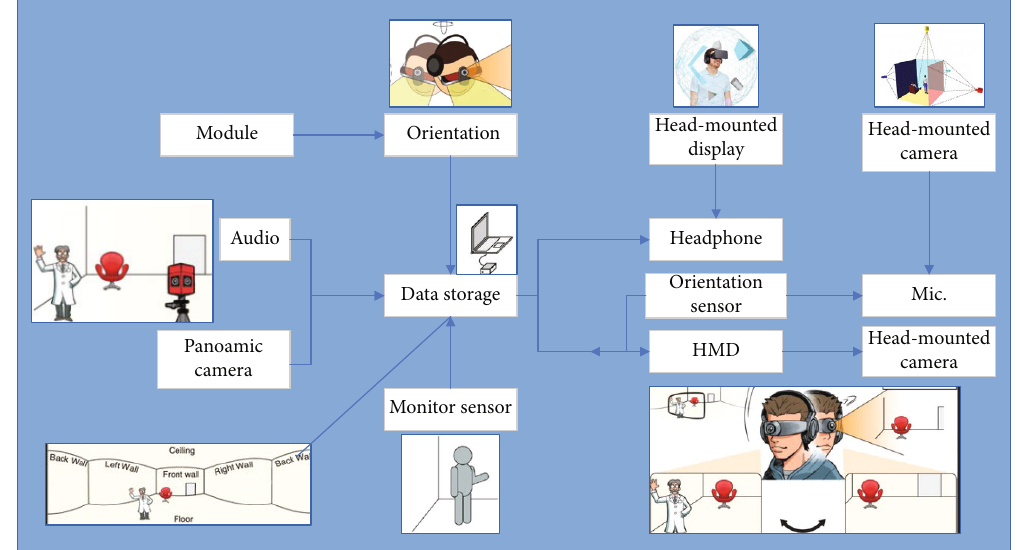
Figure 1: Principle of binocular